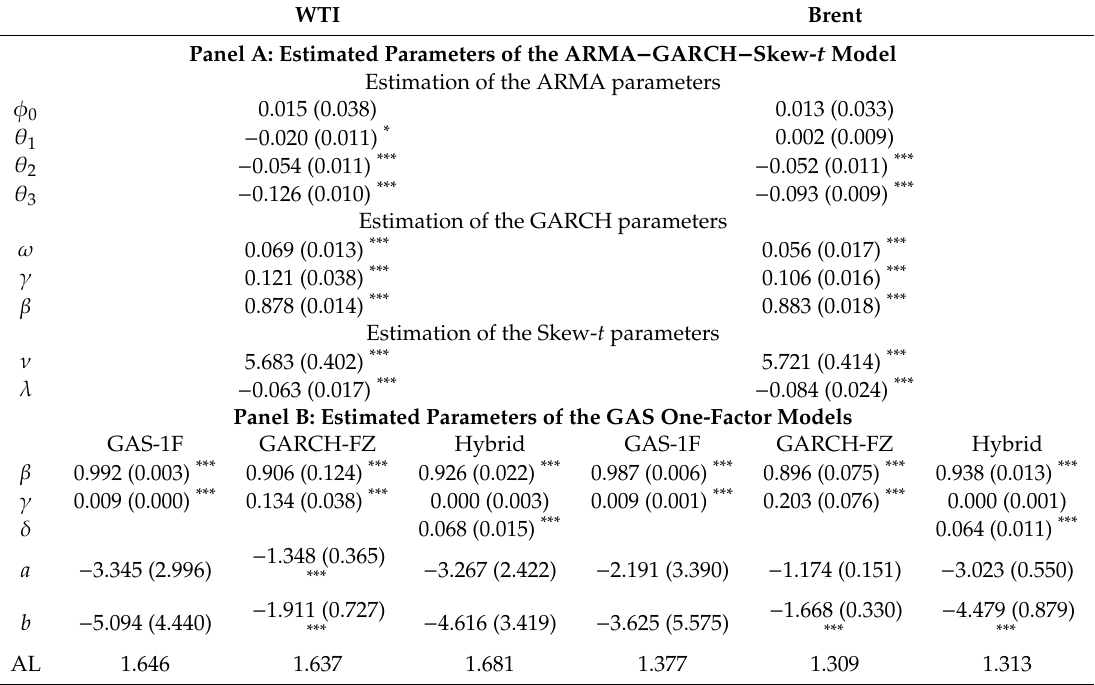
Table 2. Estimations of the autoregressive moving average (ARMA) − generalized autoregressive conditional heteroskedasticity (GARCH) − skew -t model and the generalized autoregressive score (GAS) one-factor